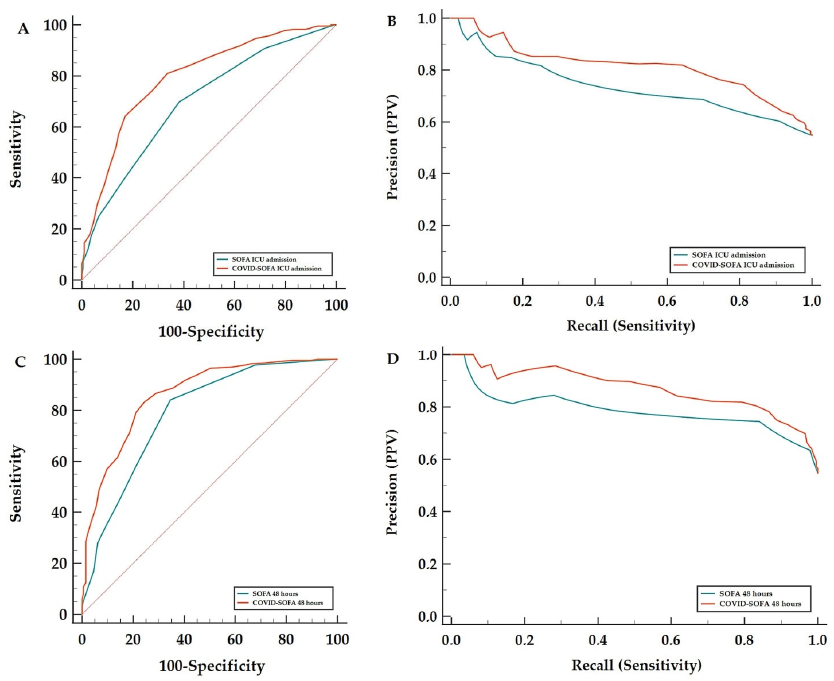
Figure 4. Area under the receiver operating characteristic (AUROC) ( A , C ) and precision-recall curves (AUPRC) ( B , D ) for SOFA and COVID-SOFA scores at ICU admission and 48 h regarding 28-day all-cause mortality ( C , D ). AUROC and AUPRC were significantly higher for the COVID-SOFA score compared with the SOFA score alone. A brief analysis of the 60 ‐ day all ‐ cause mortality based on the 28 ‐ day all ‐ cause mor ‐ tality model is available in Supplementary Material (Table S3). 3.3. Mortality Probability Calculation at All End ‐ Points Using the COVID ‐ SOFA Score The mortality probability at the studied end ‐ points can be calculated using the Cox equation rewritten for the COVID ‐ SOFA score [15]: S( t ) = 1 − e [ − CI( t ) × exp( β ( t ) × COVID ‐ SOFA)] The coefficients for COVID ‐ SOFA score at ICU admission: CI(28 ‐ day) = 0.017; exp( β )(28 ‐ day) = 1.1045 The coefficients for COVID ‐ SOFA score at 48 h: CI(28 ‐ day) = 0.010; exp( β )(28 ‐ day) = 1.1134 4. Discussion Our study describes the development and internal validation of a new predictive model in 425 critically ill patients with COVID ‐ 19. A score that has accurate predictive